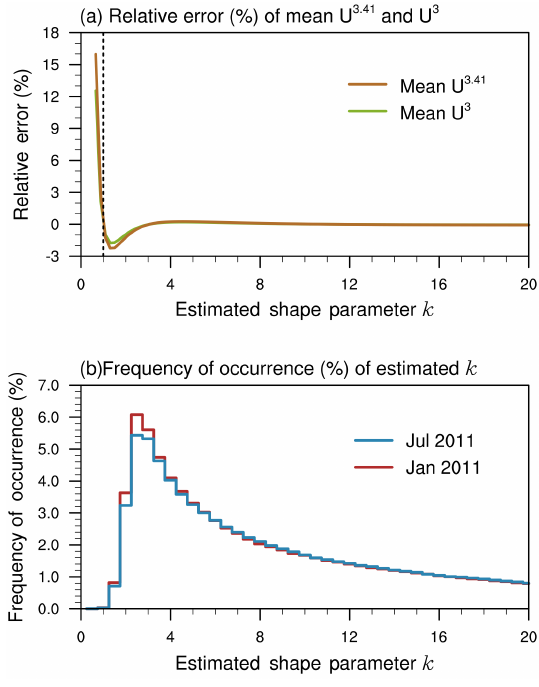
Figure 7. (a) Relative error in U 3 . 41 and U 3 as a result of estimat- 10 10 ing the shape and scale parameters of a Weibull distribution using Eqs. (15) and (16). (b) Histograms of the Weibull shape parameter k estimated with Eq. (15) using 6-hourly ECMWF analysis of Jan- uary and July 2011 for imagined 2 ◦ grid boxes. Further details can be found in Sect.